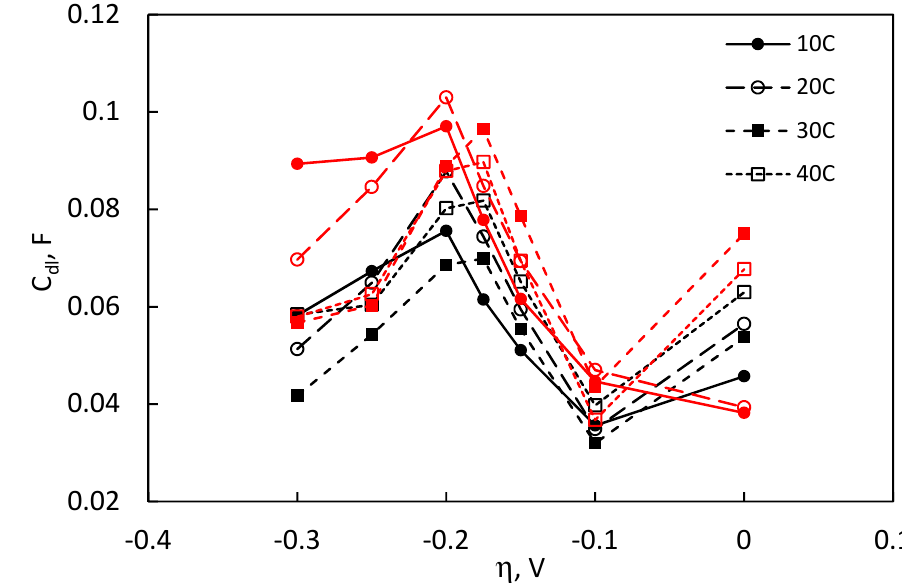
Figure 10. The dependence of double layer capacitance on overpotential. (Red lines correspond to samples, deposited with NaH 2 PO 2 ).